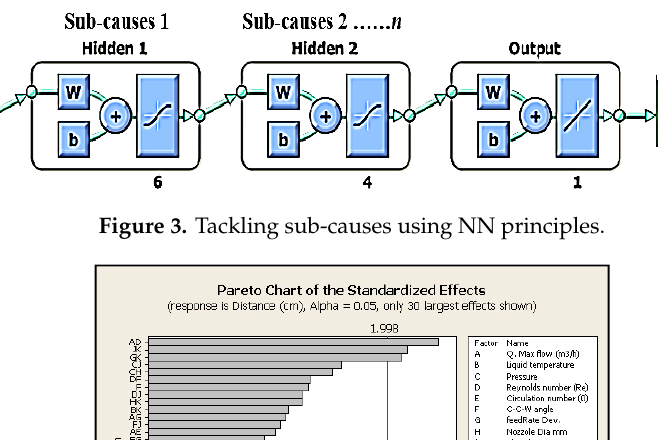
Figure 2. Cause and effect of painting process.